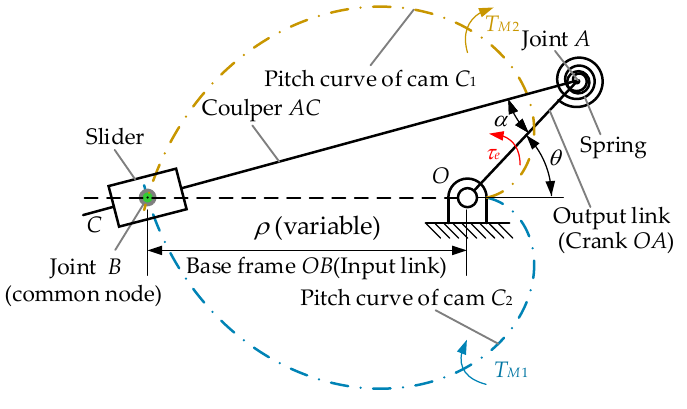
Figure 1. Principle of the cam-based VSA.